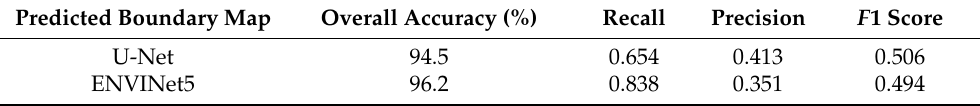
Table 6. Accuracy assessment and comparison with ENVINet5. Predicted Boundary